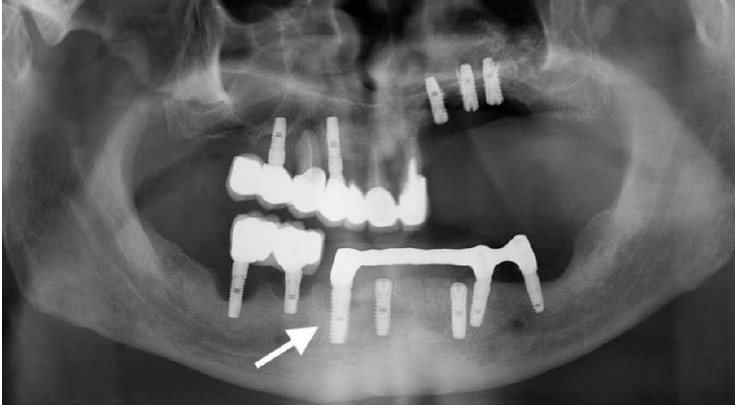
Figure 5. OPG radiography. Peri-implantitis in quadrants 3 and 4 through bone loss identified up to the apical segment for the implant in position 4.3 and generalized horizontal bone loss around the other implants.